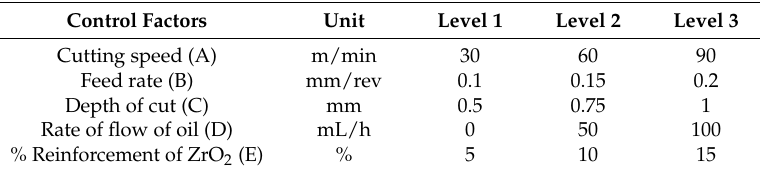
Table 1. Control factors and their